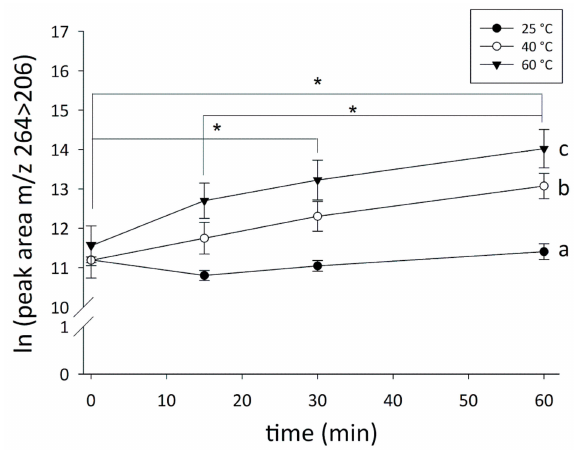
Figure 3. Time- and temperature-dependent formation of 2-pentyl-3,5-dibutyl-dihydropyridine. The mixture of PE (16:0 / 18:1) (0.8 mM) and hexanal (1.6 mM) was incubated at 25, 40 and 60 ◦ C for 0, 15, 30 and 60 min. After natural log-transformation to obtain a normal distribution, two-way analysis of variance (ANOVA) with the Holm—Sidak method was applied ( p < 0.05). Significant di ff erences in time are presented with asterisks and di ff erences between temperatures are expressed with di ff erent letters. Values ( n = 5) are presented as mean ± SEM. Filled circle: 25 ◦ C; circle: 40 ◦ C, filled triangle: 60 ◦ C.